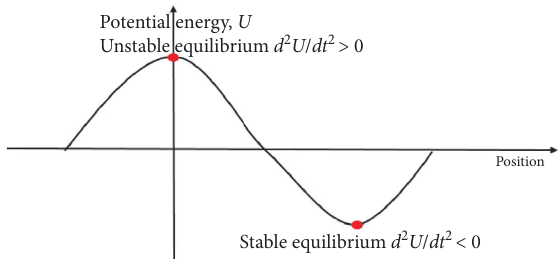
Figure 2: Convex and concave region of the Lyapunov function.